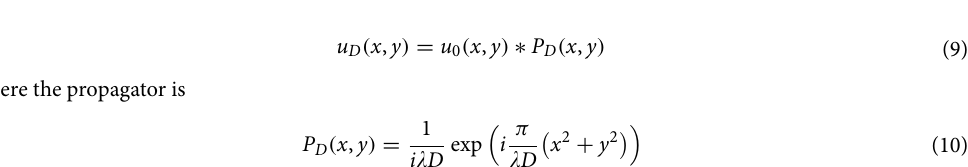
Figure 14. ( a ) Voxelized phantom: Rectangular block of Al-Si alloy with crack (voxel size 1 µ m). ( b ) Simulated projection(0 ◦ ) with phase contrast, the Fresnel diffraction patterns can be seen on crack interfaces. ( c ) Distribution of gray scale values along the red dashed line in the